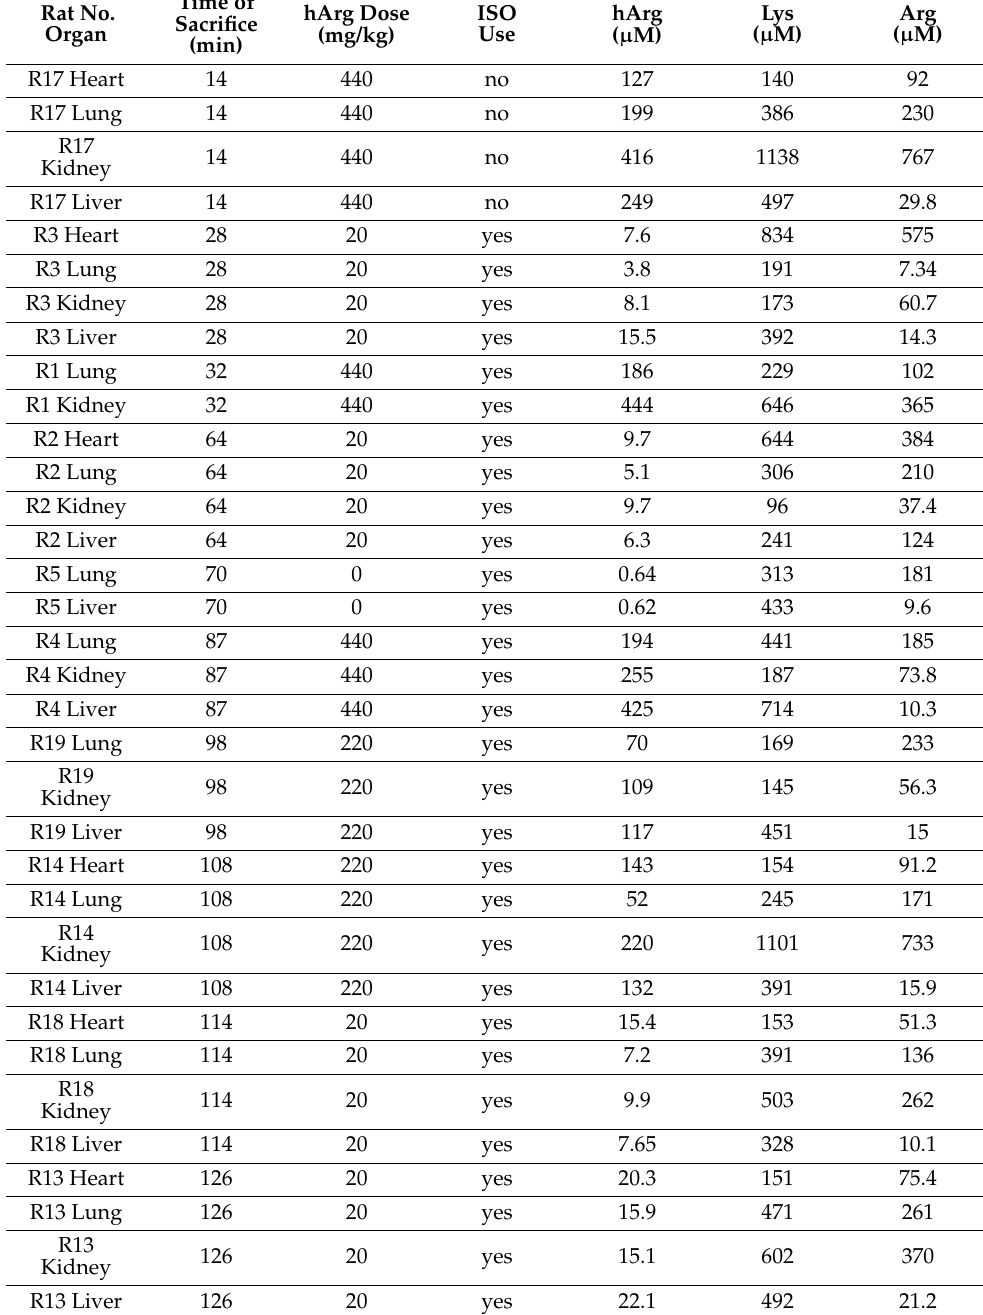
Table 2. Time of sacrifice, hArg dose, isoprenaline (ISO) administration and concentrations of free homoarginine (hArg), free lysine (Lys), and free arginine (Arg) measured in the tissue homogenates of the analyzed organs of the rats at the indicated time points. See also Table 1. Rat No.